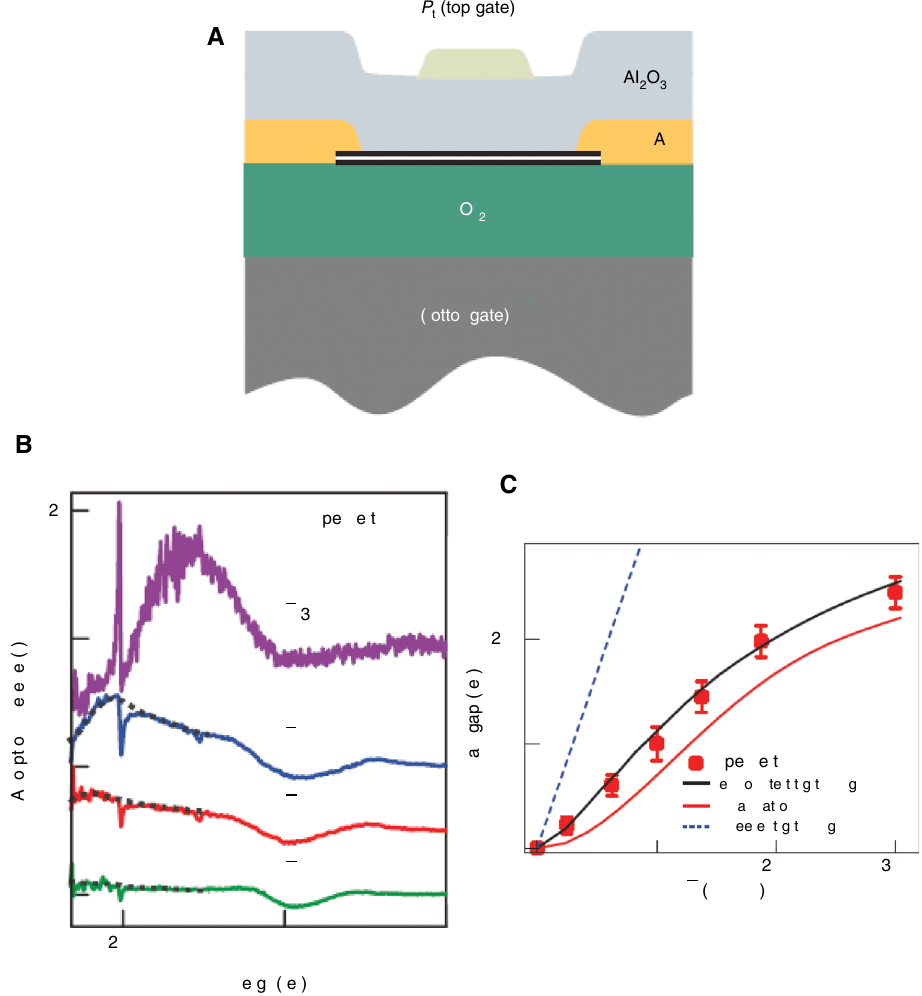
Figure 2 Band-gap opening in dual gated bilayer graphene. (A) Sketch of the dual gated bilayer graphene device. (B) Infrared absorption spectra for different electrical displacement fields. The Fermi level is at charge neutral point. The spikes and dips at ∼ 200 meV are due to the optical phonon of the bilayer graphene. (C) Band gap as a function of the electrical displacement field. The black solid curve is from the self-consistent tight-binding calculation and the red curve is from DFT calculation. The dashed line is based on the unscreened tight-binding model (A–C reproduced with permission from [22], Copyright 2009 Nature Publishing